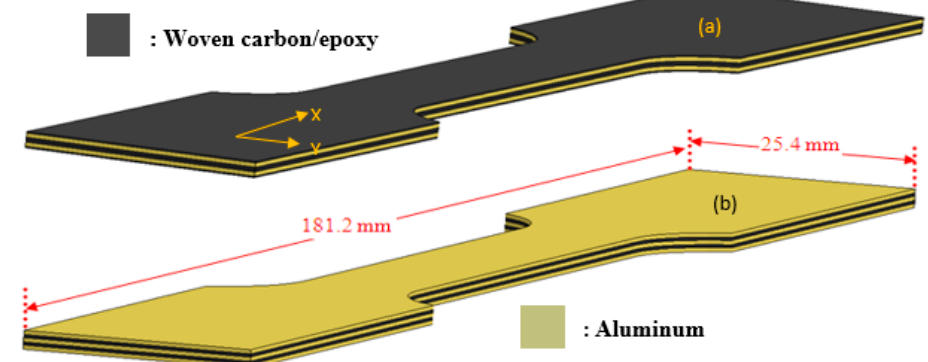
Figure 12. Thermal residual stress FE model schematics of CARALL-A & B tensile specimens. ( a ) CARALL-B Specimen ( b ) CARALL-A specimen.